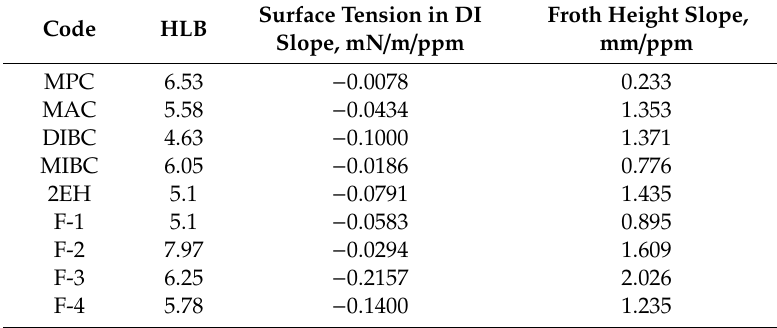
Table 4. Supplemental physical properties of all the nine evaluated